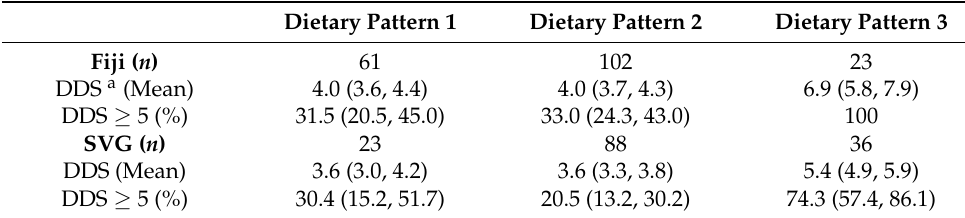
Table 2. Dietary diversity score by dietary patterns. Figures in brackets are 95% CIs. Dietary Pattern 1 Dietary Pattern 2 Dietary Pattern